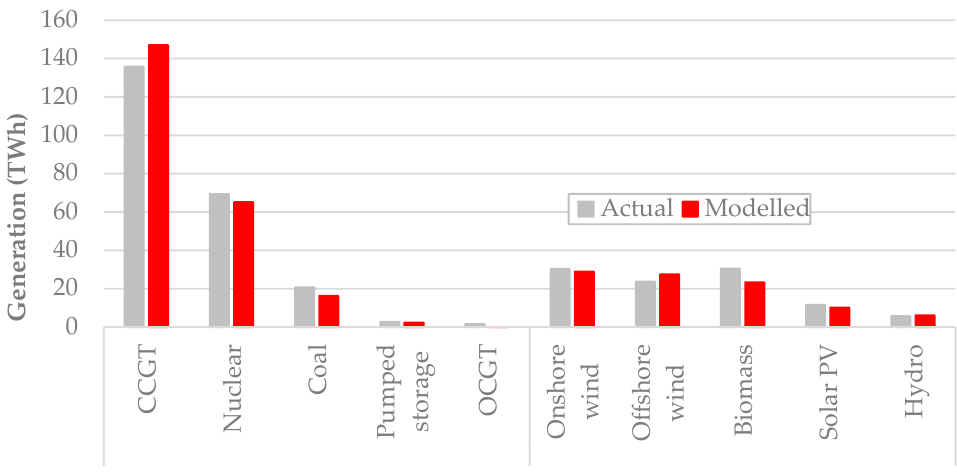
Figure 3. Comparison of actual [7] and modelled annual generation.